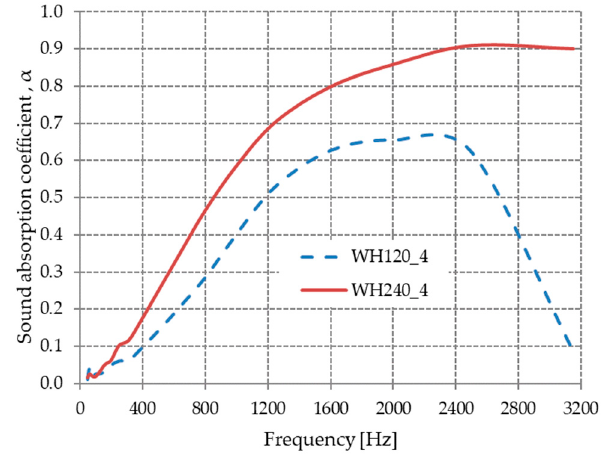
Figure 6. Variation in the acoustic absorption coefficient with the material thickness for WH120_4 and WH240_4.